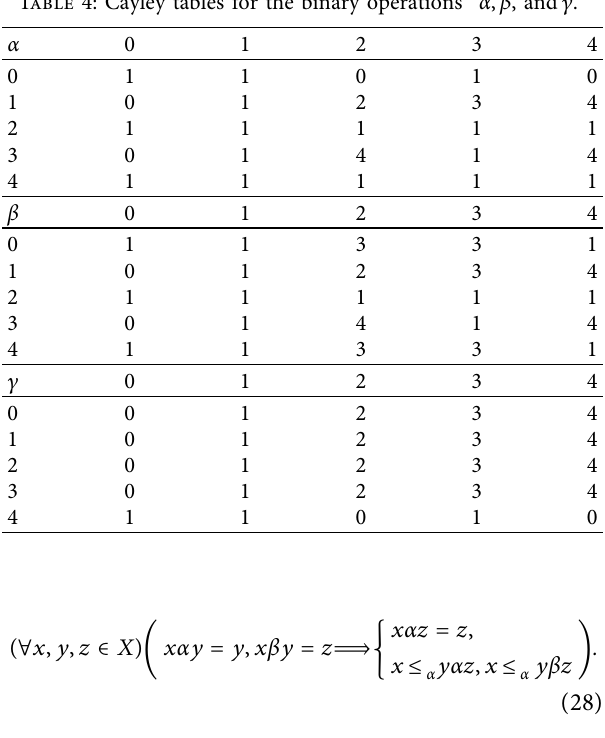
Table 2: Cayley tables for the binary operations “ α , β , and c .”